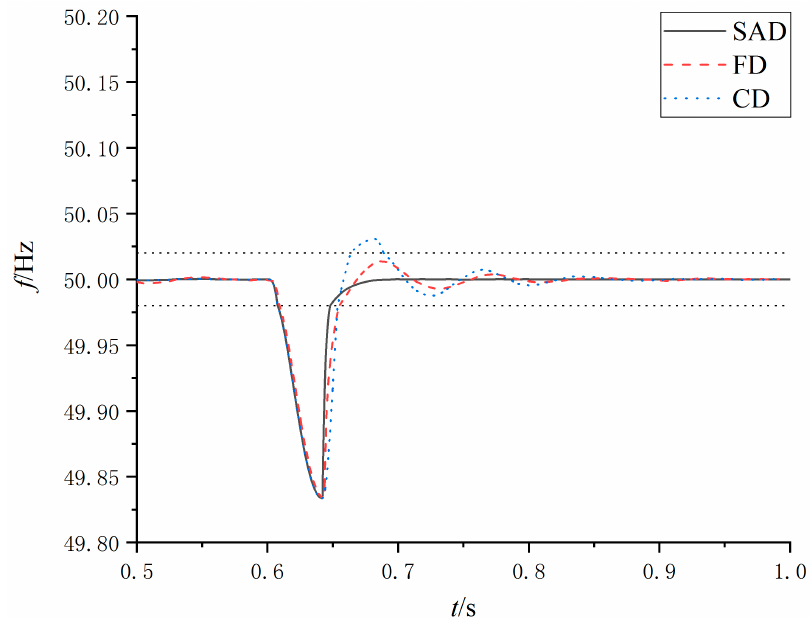
Figure 12. Comparison of frequency under di ff erent damping control strategies when J is based on a bang-bang control